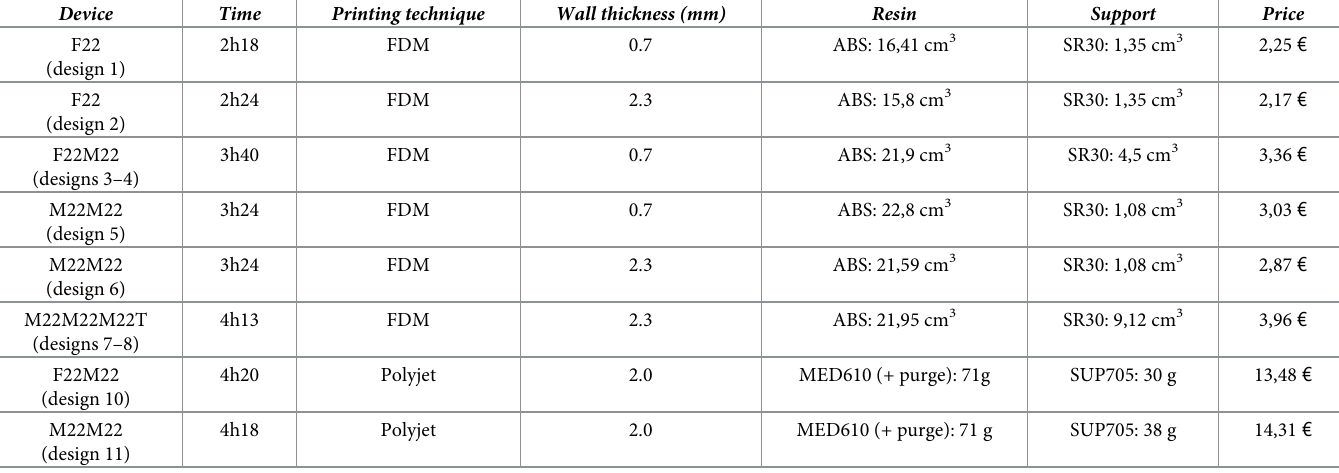
Table 4. FDM and Polyjet printing time, requirements in raw materials and